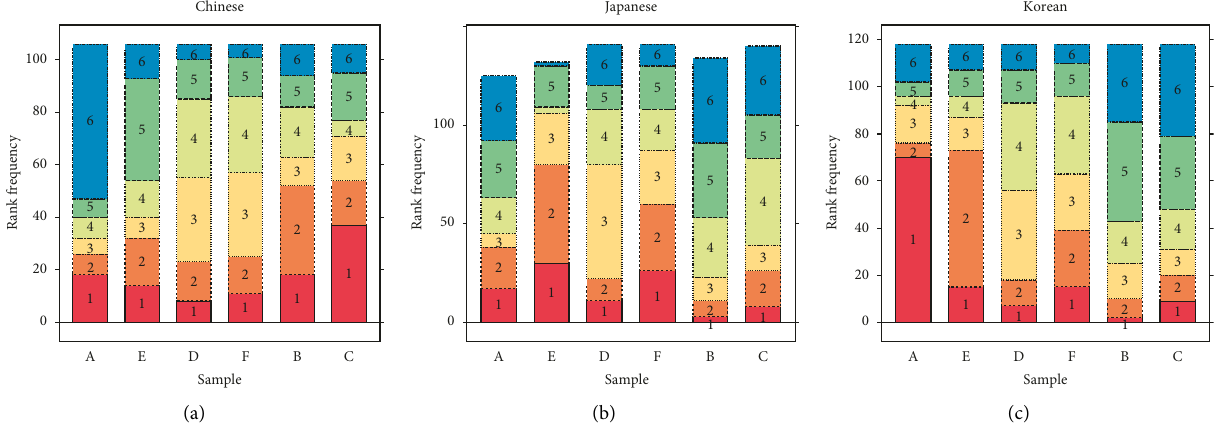
Figure 4: The frequencies of the rank for each sample, with the rank of 1 as the least preferred and 6 the most preferred. Samples are ordered from highest (A) to lowest (C) percentage of visible fat along the x -axis. A � 35%, E � 28%, D � 24%, F � 15%, B � 14%, and C �